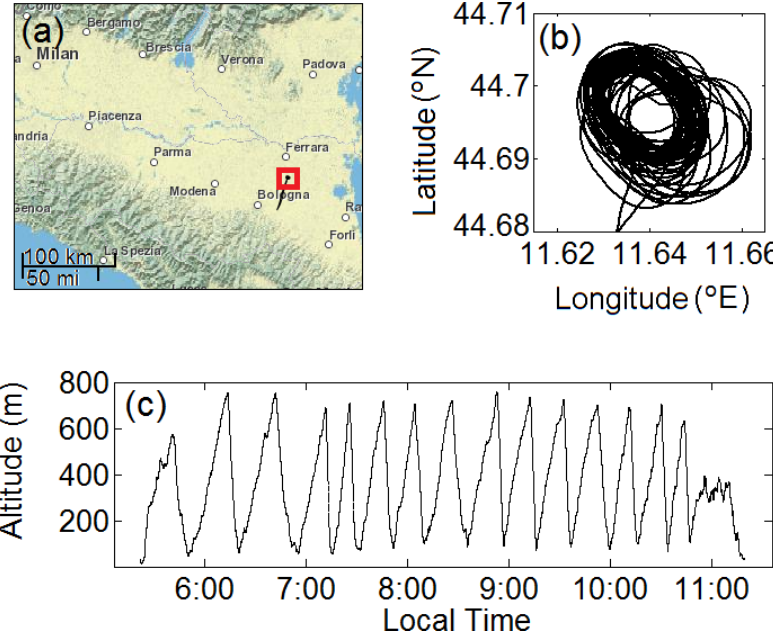
Figure 1. (a) Po Basin, with the 12 July 2012 flight track shown in the box and enlarged in (b) . (c) Zeppelin altitude during